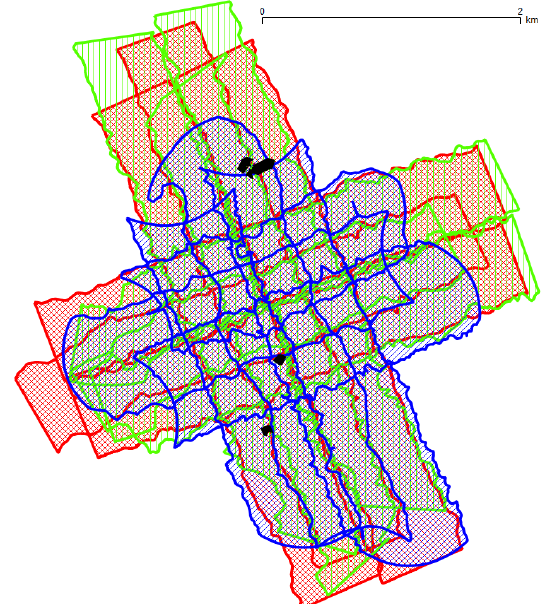
Figure 1. 2D overview of the study area Horn (Austria); boundaries of the ALS strips: RIEGL VQ-820-G (blue); RIEGL VQ-580 (green); RIEGL LMS-Q680i (red); areas with in-situ reference surfaces (black).